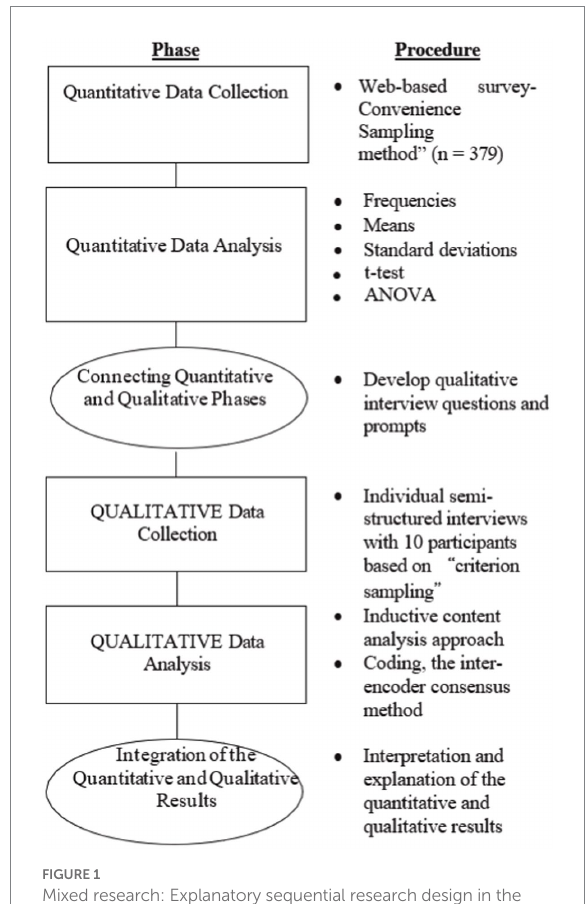
FIGURE 1 Mixed research: Explanatory sequential research design in the present